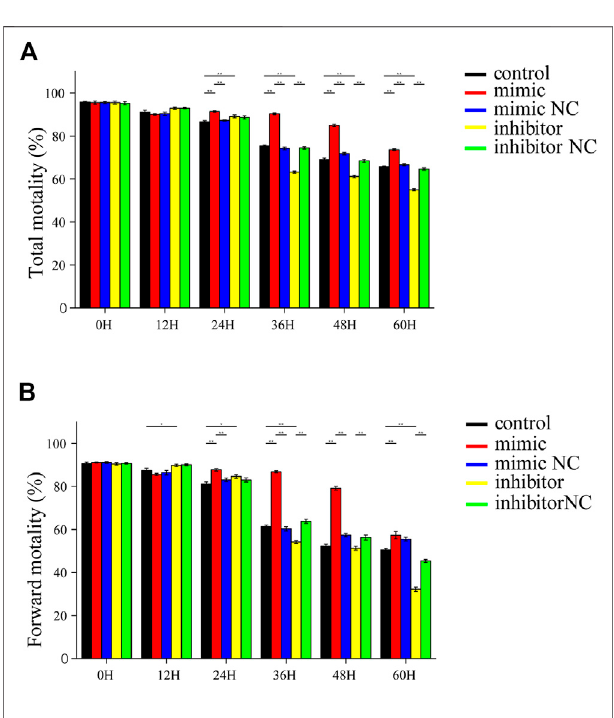
FIGURE 3 | Sperm motility and forward motility in piR-121380 transfected sperm at 17 ° C. (A) Total sperm motility after transfection. (B) Sperm forward motility after transfection. The data are representative of at least three independent experiments (mean ± SEM).